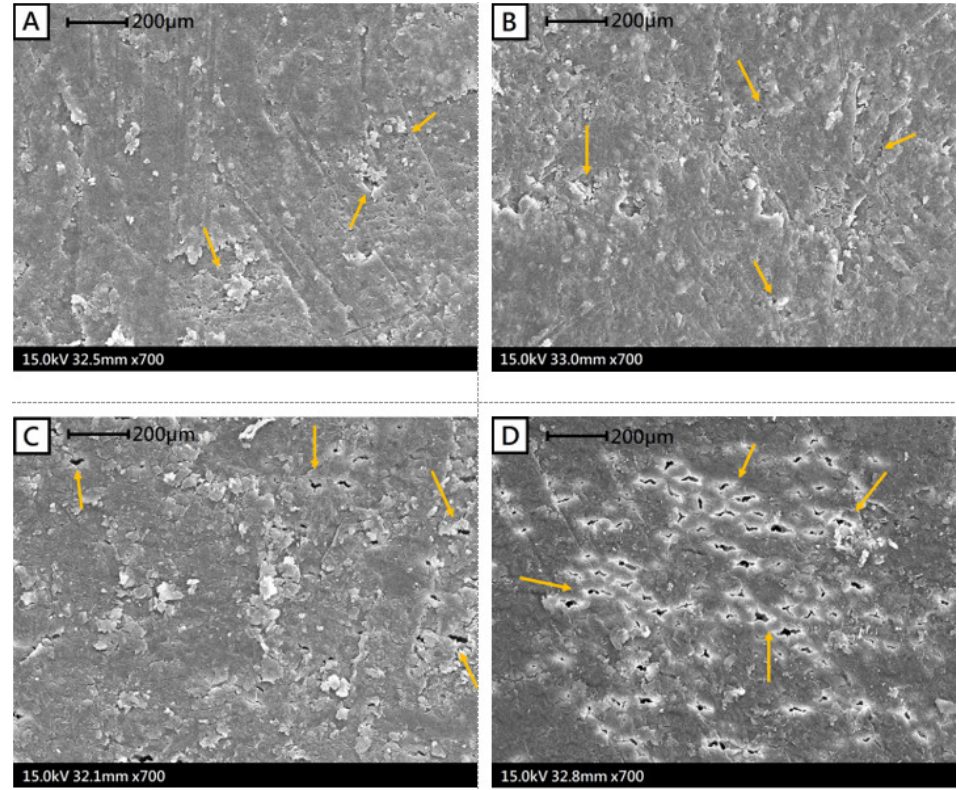
Figure 5. The microstructure (SEM, 15 kV, 700 X) of seed coat surface of control seed ( A) ; soaking- treated seed ( B) ; high-voltage electric field-treated seed ( C) ; soaking + high-voltage electric field- treated seed ( D) . The arrows indicate treatment-induced cracks on the seed coat surface.